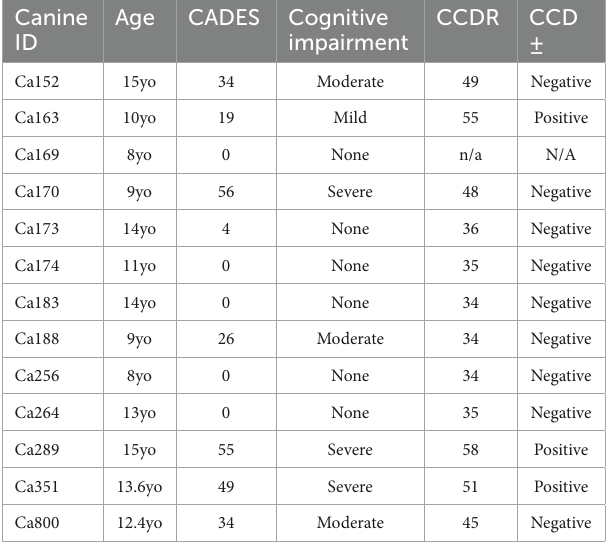
TABLE 3 Scores of canines with CADES and CCDR owner